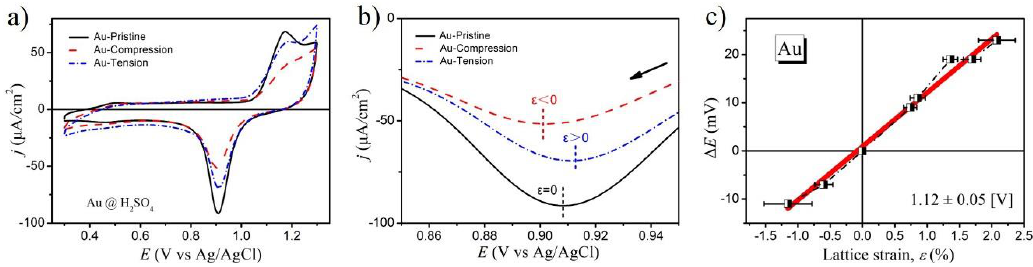
Figure 3. a ) Cyclic voltammogram (CV) curves of the Au surface under different strain states at 10 mV·s −1 in 10 mM H 2 SO 4 . b ) Oxygen desorption peak of the Au electrodes. c ) The desorption potential 10 mV · s − 1 in 10 mM H 2 SO 4 ; ( b ) Oxygen desorption peak of the Au electrodes; ( c ) The desorption variation is plotted as a function of the lattice strain. potential variation is plotted as a function of the lattice